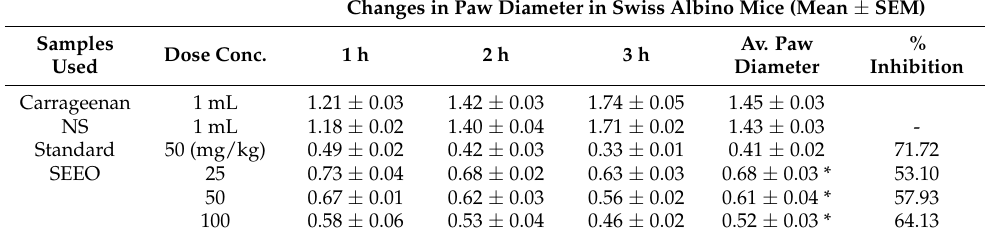
Table 3. Anti-inflammatory significance of S. edelbergii